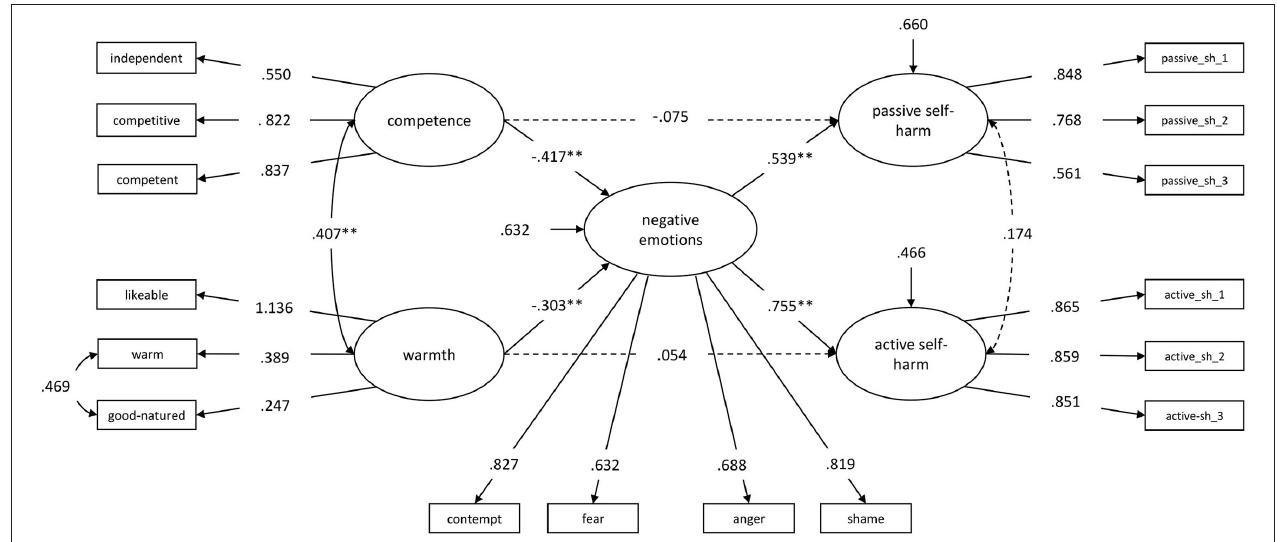
FIGURE 1 | Warmth and competence, predicting passive and active self-harm via negative emotions (Model 1.0). Standardized regression weights. Dashed lines are not significant ( p > 0.05). * p < 0.05, ** p < 0.01. sh = self-harm.